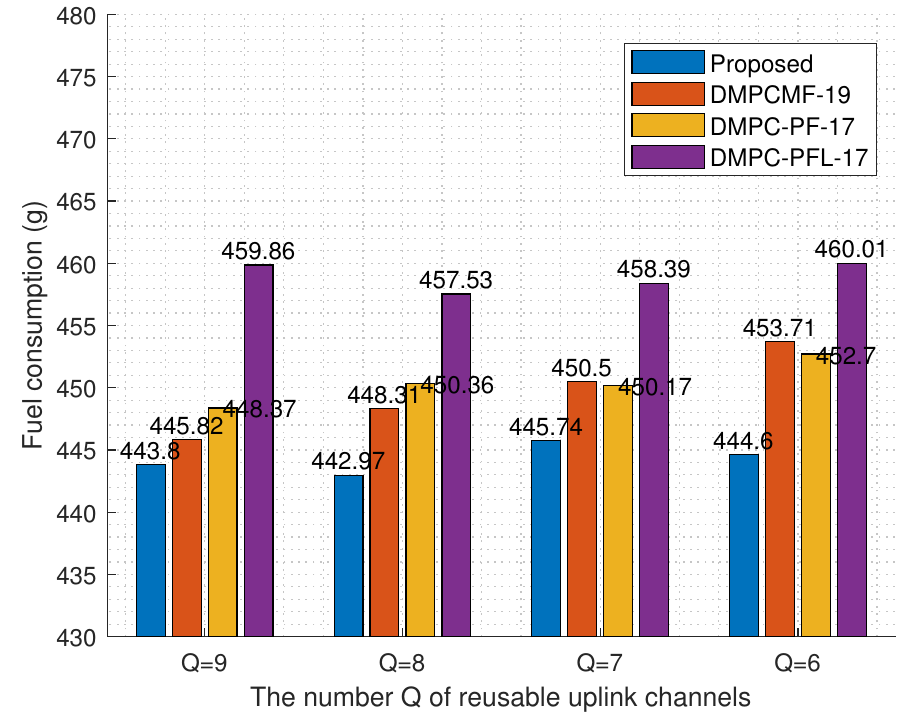
Figure 10. Comparison of fuel consumption of different algorithms with different numbers of reusable uplink